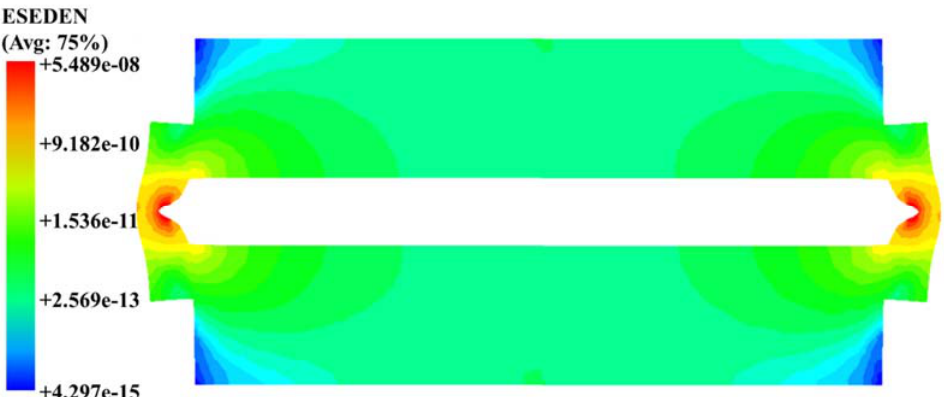
Figure 3. Plot of the ESEDEN of the USC, in which the ESEDEN denotes the ESE density. The logarithms of ESEDEN and the color coding are corresponding. The USC length L is 80 mm. For the demonstration, the deformation amplified by a factor of 1 × 10 6 has been adopted.